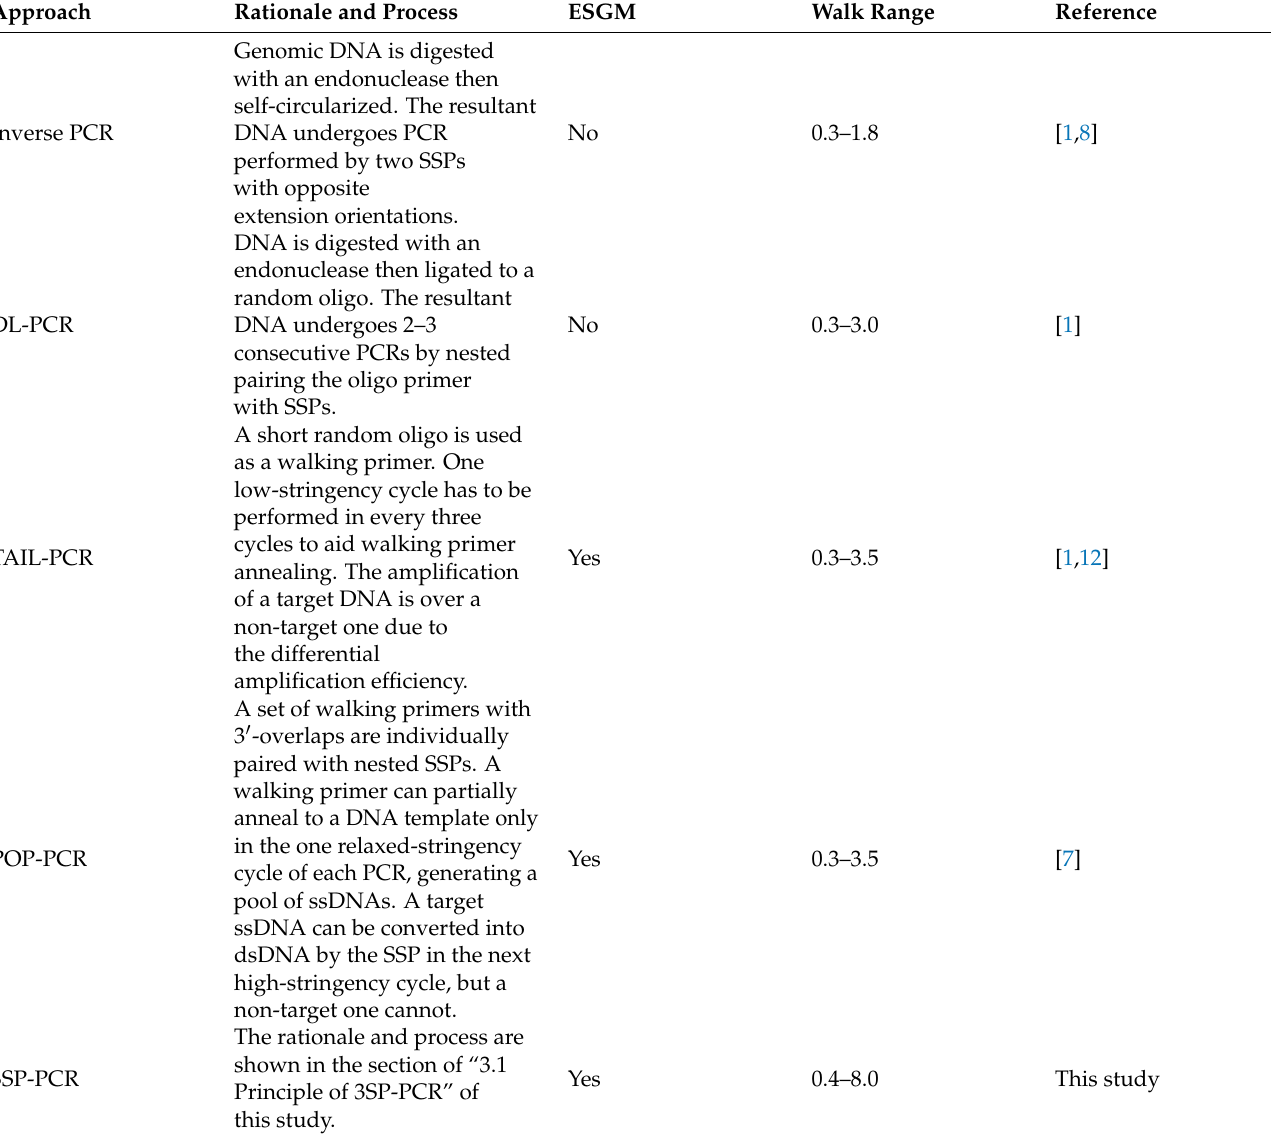
Table 3. Comparison of 3SP-PCR with the available PCR-based